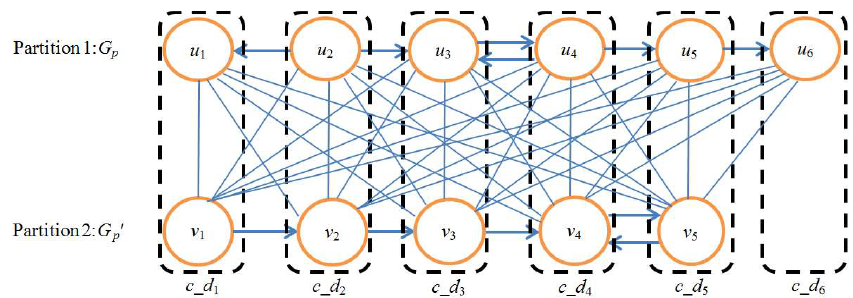
Figure 9. Example of union graph. The upper path is G p and the lower path is G p ′. u i → u j denotes that the output compound of u i is the input compound of u j , v i → v j denotes that the output compound of v i is the input compound of v j , i , j = 1, 2, 3, 4, 5, 6. V ( G p ) and V ( G p ′) are regarded as two partitions of bipartite graph G b . Solid lines denote the edges of G b . Each edge of G b corresponds to a one-to-one node mapping between G p and G p ′. The mappings in rectangles are the node mappings selected by the MWBM algorithm. Each selected node mapping constructs a composite node c _ d i , i = 1, 2, 3, 4, 5, 6. A union graph of G p and G p ′ is constructed by these six composite nodes.